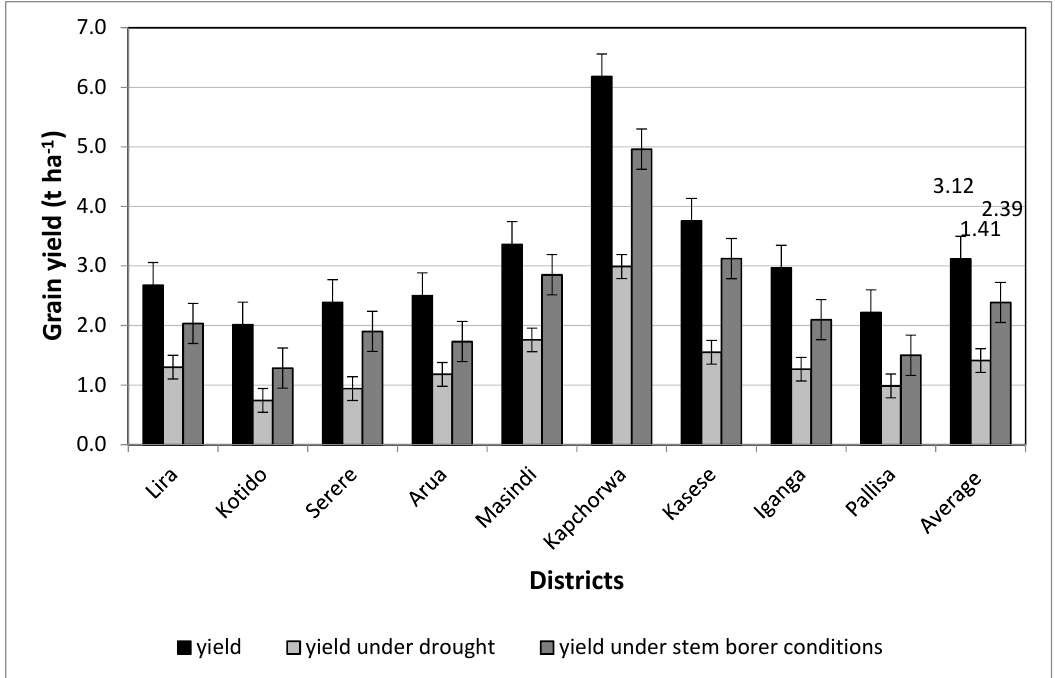
Figure 2. Average maize grain yields without and with drought or stem borer damage in the nine Ugandan districts surveyed, including the average across all districts. The means are based on 50 farmers in each district.